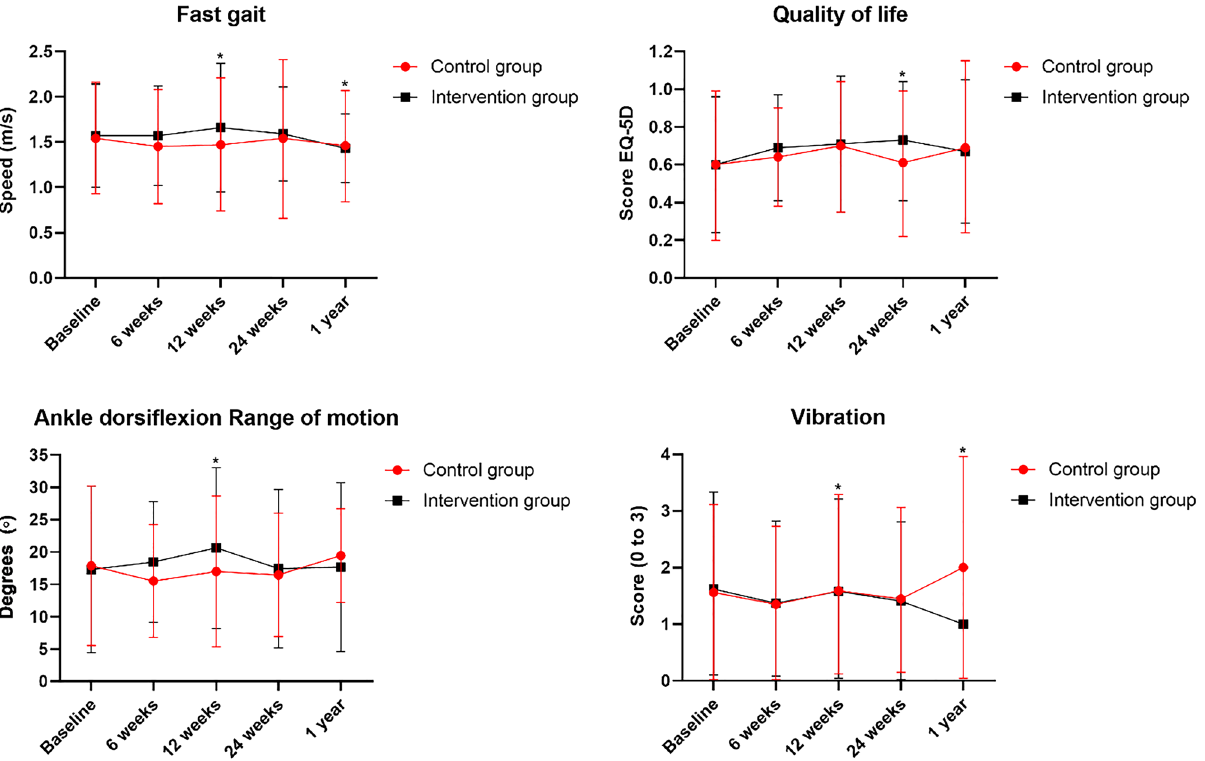
Figure 2. Different between intervention group and control group on fast gait speed, quality of life, ankle range of motion and vibration